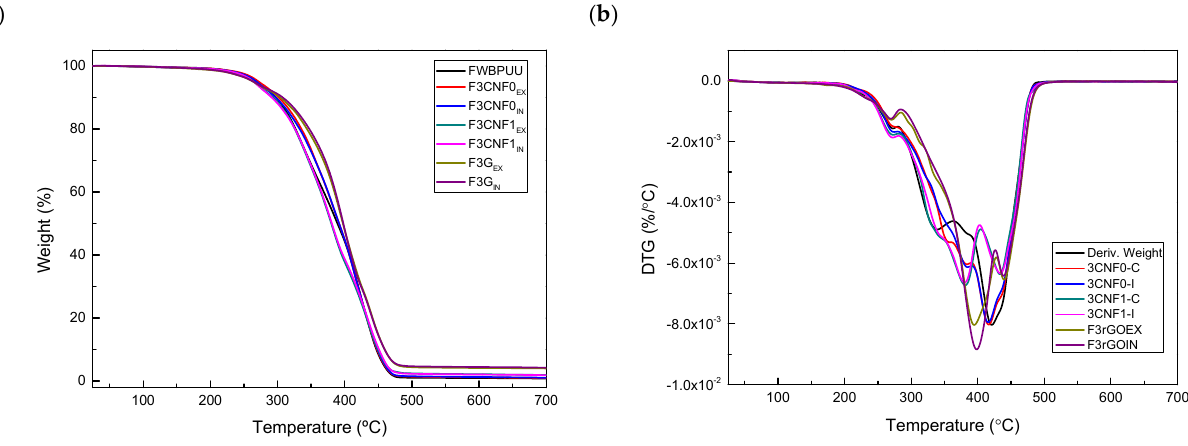
Figure 7. ( a ) TGA and ( b ) DTG curves for matrix and composite filaments.